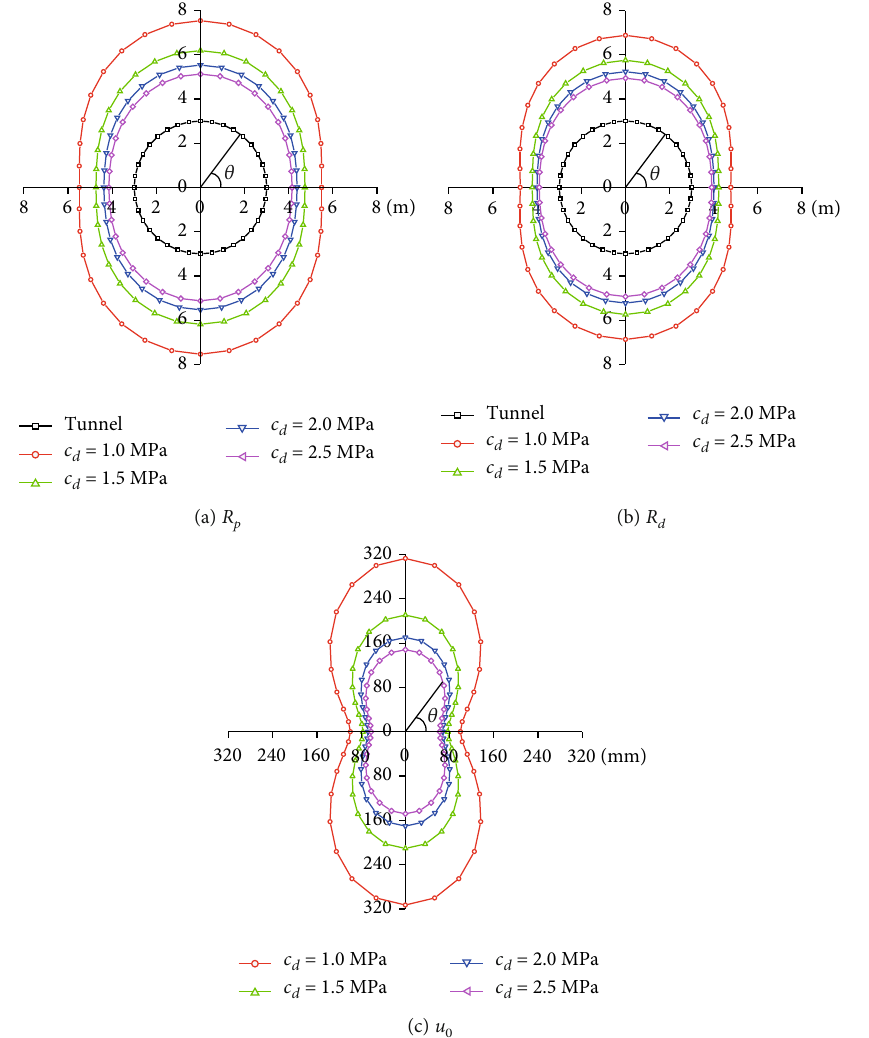
Figure 9: Postpeak zone radii and surface displacement around the tunnel under di ff erent types of residual cohesion.